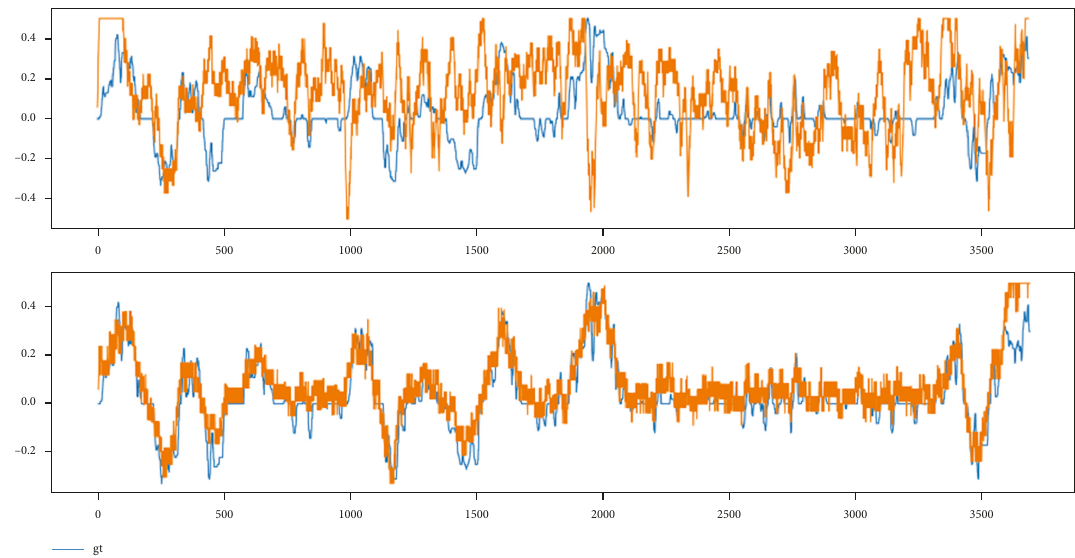
Figure 11: Steering recorded by human decisions (blue) and our algorithm (orange). Our method is scaled down to half for better comparison.